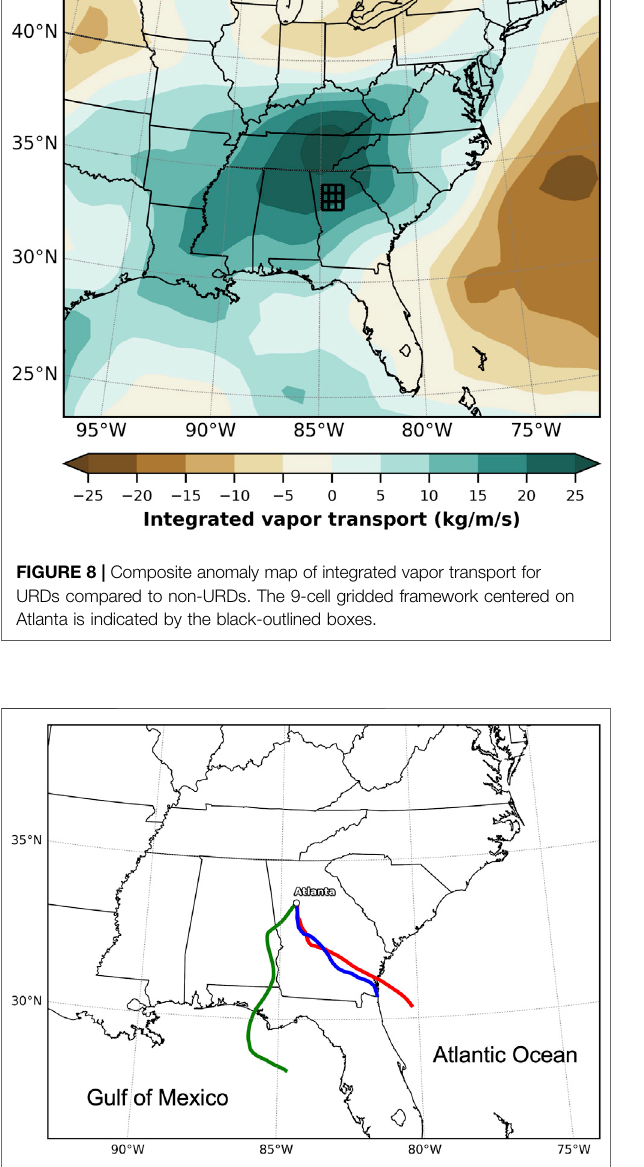
FIGURE 9 | HYSPLIT backward trajectory analysis for the 99th percentileandgreaterURDs( n =17 days).Thetrajectoriesarecolor-codedas follows: 10 m above ground level (red line), 500 m above ground level (blue line), and 1,500 m above ground level (green line).